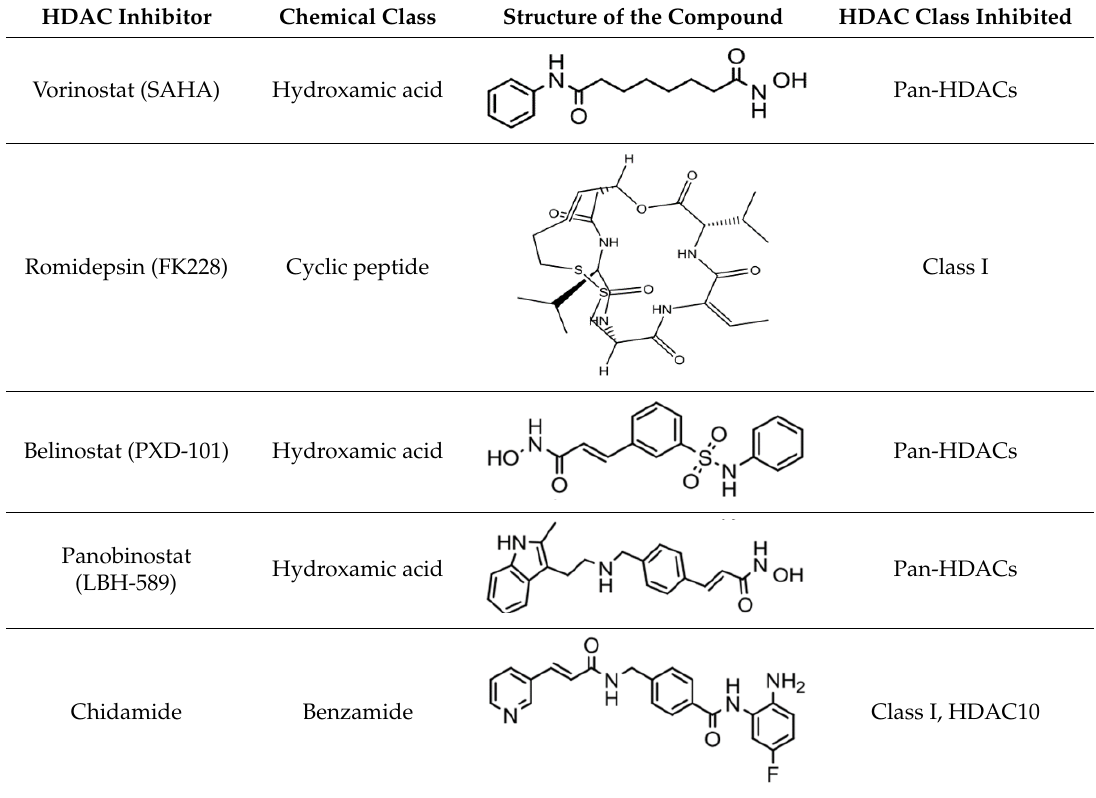
Table 2. The HDAC inhibitors approved for clinic use.